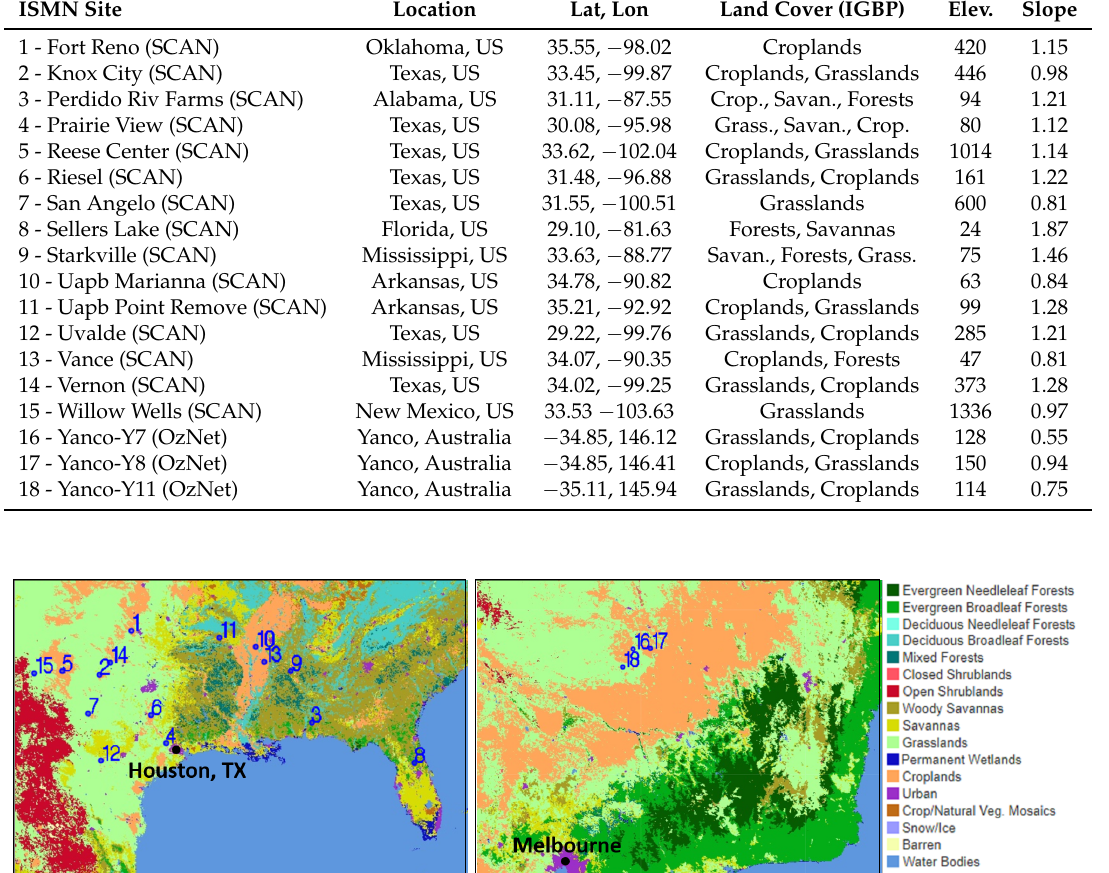
Figure 3. ISMN site locations with the IGBP land cover classification in the background. ( Left ): SCAN sites from USA, ( Middle ): OzNet sites from Australia, ( Right ): IGBP land cover classification color-code. Indices are same with Table